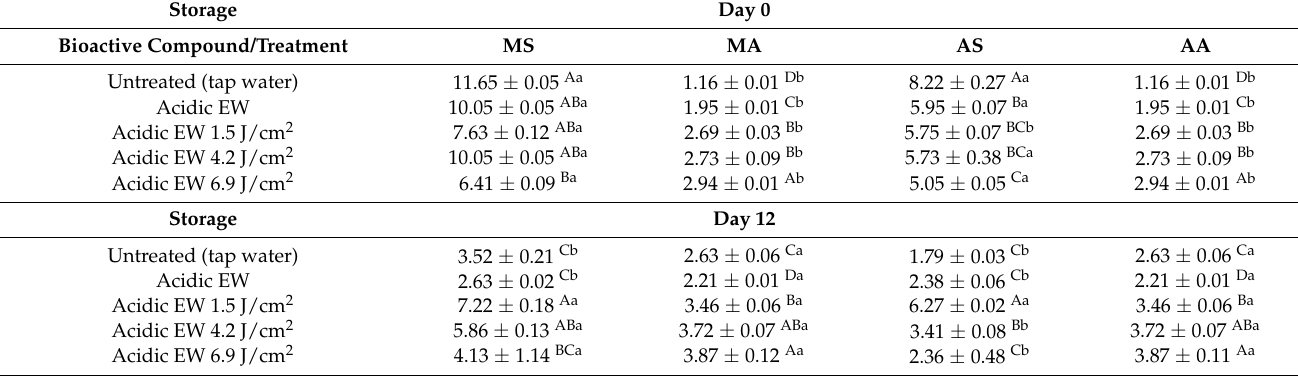
Table 3. Bioactive compound of madecassoside (MS), madecassic acid (MA), asiatic acid (AA) and asiaticoside (AS) in pennywort